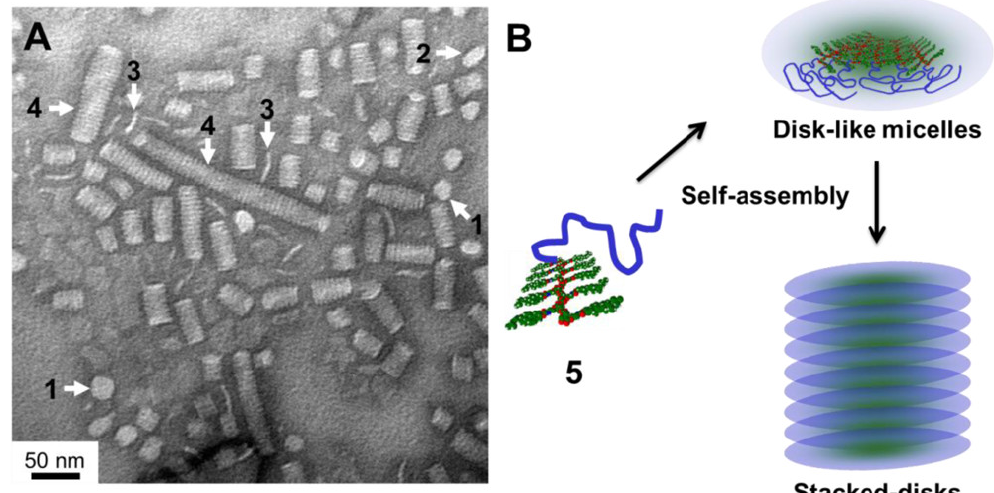
Figure 3. ( A ) TEM micrographs of stained aqueous self-assembled nanostructures formed by mPEG 113 -b-P(MTC-Chol) 11 . Arrows 1–3 show the face-on, intermediate ellipsoidal, and edge-on orientations of the structures, respectively; arrow 4 shows the stacked-disk orientation ( B ) Schematic representation of the mechanism driving the formation of stacked-disk micelles. Reprinted with permission from Venkataraman et al., Macromolecules , 2013 , 46 , 4839–4846